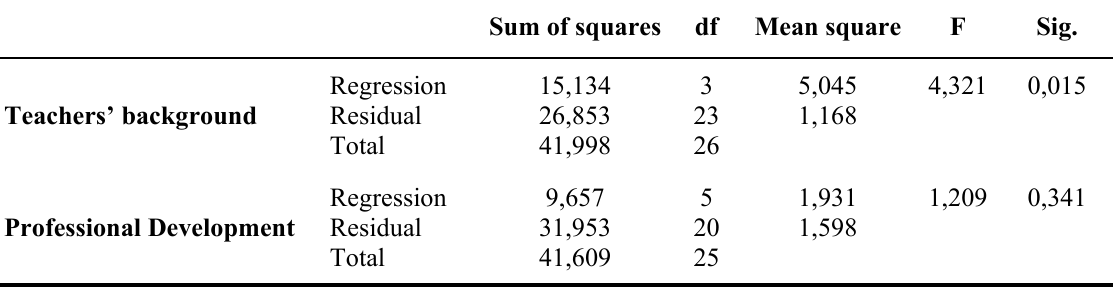
Table 11 : Combined effects of the indices of teachers’ background, professional development Sum of squares df Mean square F